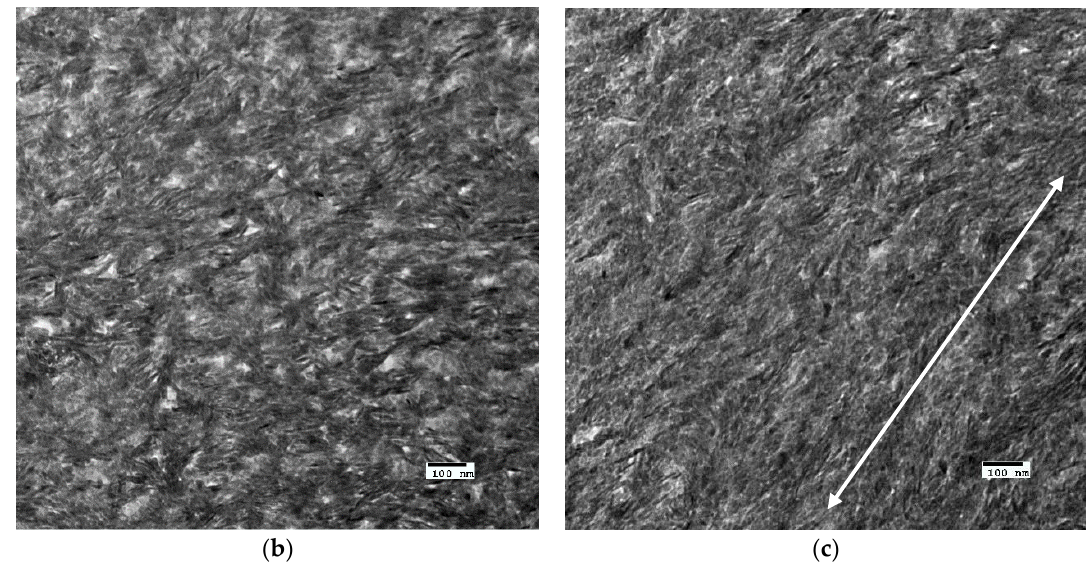
Figure 5. Nanoscale mineral patterns templated by parallel arrays of collagen fibrils in X76, visualized in bright field TEM. ( a ) Low magnification TEM image that shows two different collagen/mineral orientations in neighboring lamellae, the boxes marked ‘b’ and ‘c’ correspond to the high magnification images shown in Figure 5b,c, respectively; ( b ) Acicular mineral pattern similar to the “lacy” regions described by Reznikov et al., whose tomographic reconstructions depicts mineral crystals bending around collagen fibrils when viewed end-on; and, ( c ) Co-alignment of the collagen fibril axes and the fast-growing crystallographic c -axes (orientation shown by double-sided white arrow) of elongated mineral crystals results in this “filamentous” pattern, in which the mineral has classically been described as having a needle or plate-like morphology.